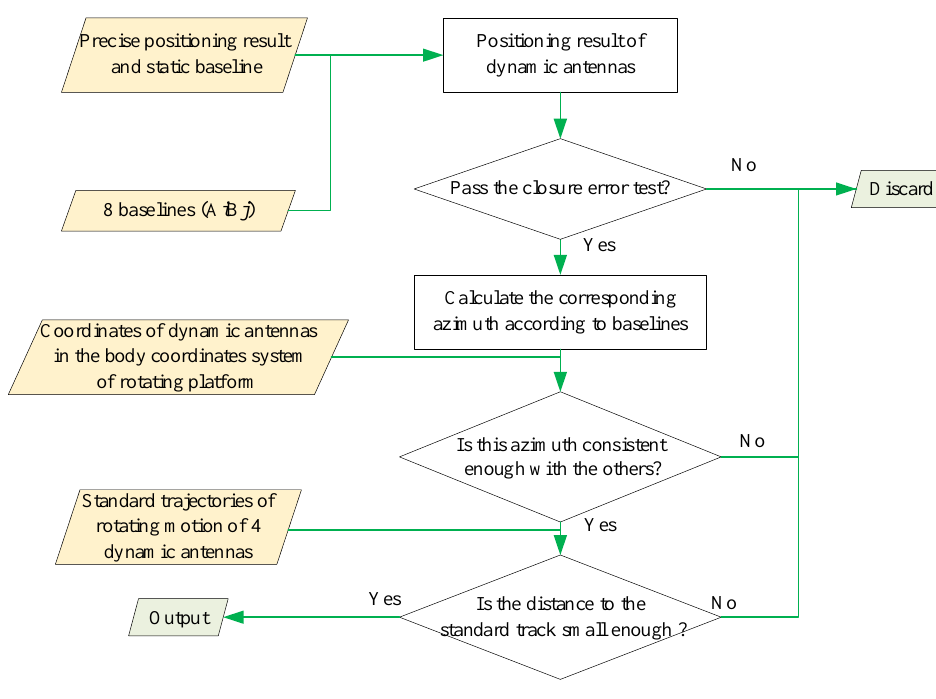
Figure 5. The contents of the multiple testing.